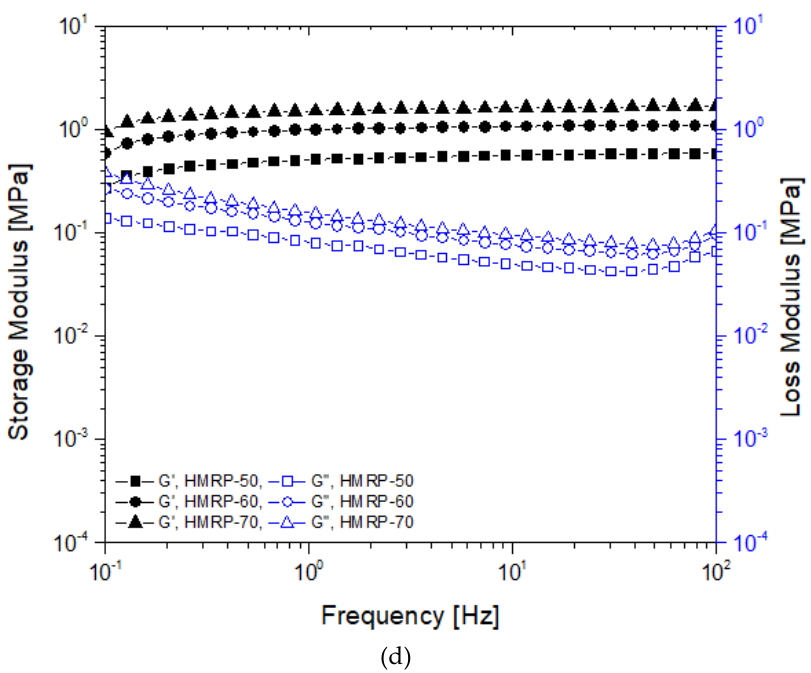
Figure 3. Storage (solid) and loss (open) moduli for PVA HMRP samples as a function of the frequency with di ff erent CIP contents at the magnetic field of ( a ) 0, ( b ) 180, ( c ) 370, and ( d ) 540 mT.